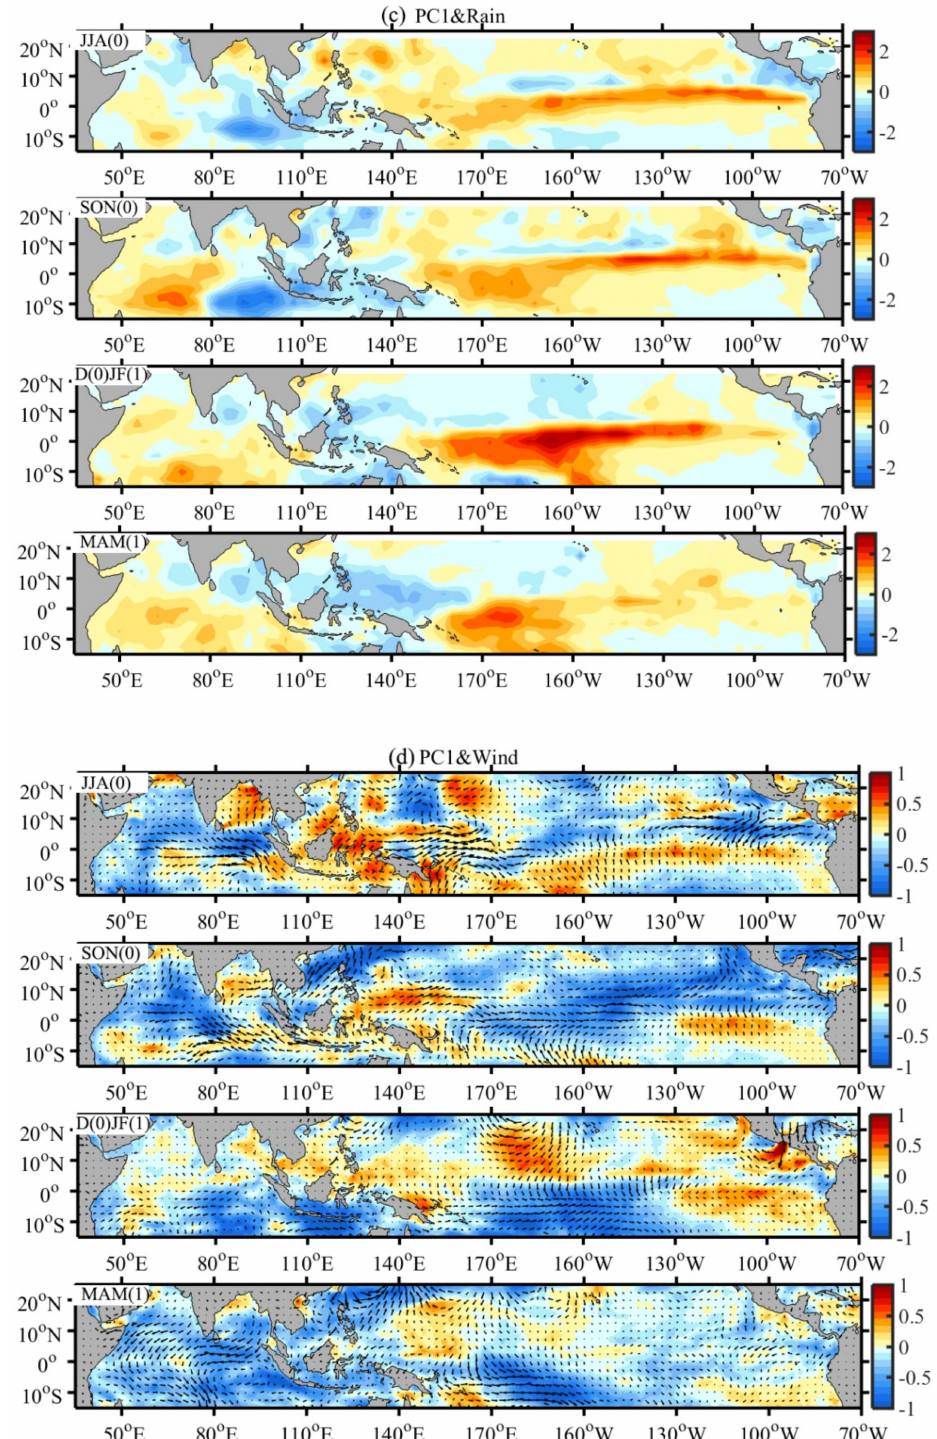
Figure 7. Seasonal evolution patterns of ( a ) SST, ( b ) SLA, ( c ) Rain, and ( d ) Wind anomalies across the tropical Indo-Pacific Ocean, synchronously regressed with the principal component of